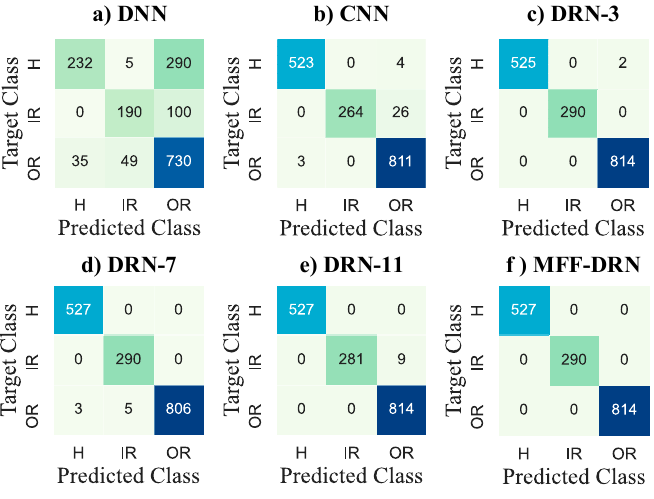
Figure 11. Confusion Matrix Comparison in Case 2. Table 7. Comparison of MFFDRN with some advanced methods in Case 2.